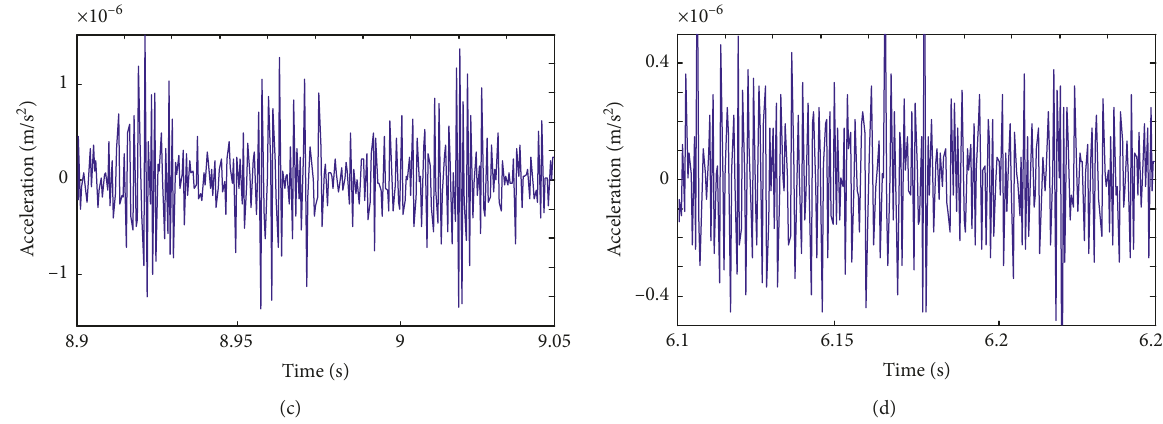
Figure 15: Experimental beat vibration waveforms of middle measurement section on casing at different rotating speeds: (a) ω ω l 80rad/s, (b) ω h (cid:30)